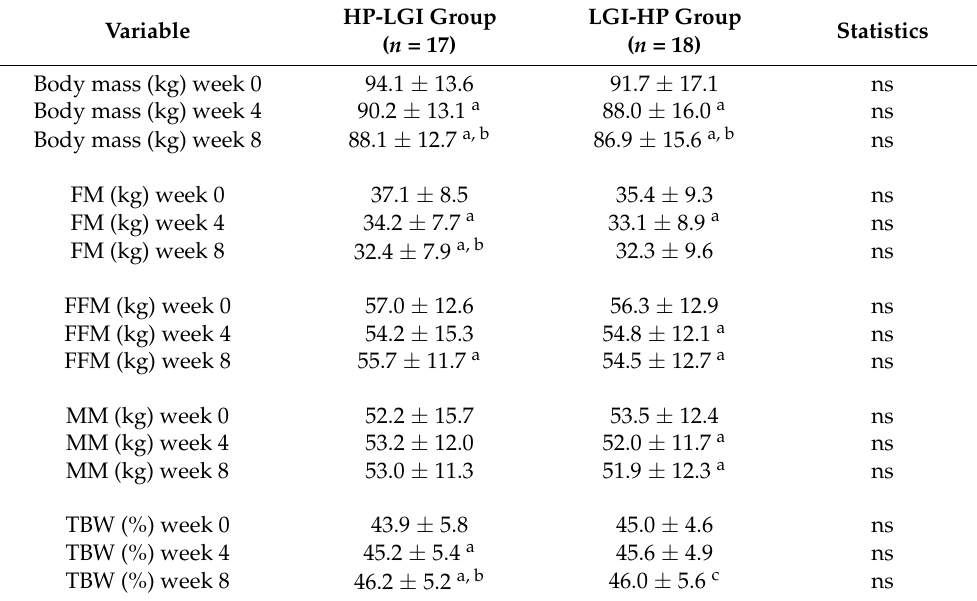
Table 3. The changes in body mass and body composition—during the 8-week period of energy- restricted diets: 4-week high protein (HP) or low glycemic index (LGI) diet given in a random order and followed by the opposite